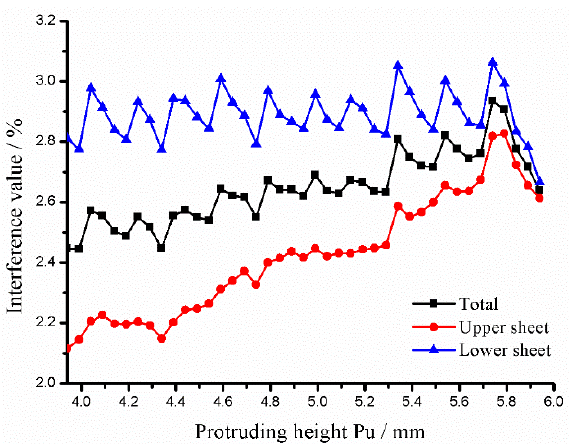
Figure 9. The average interference value obtained from different protruding